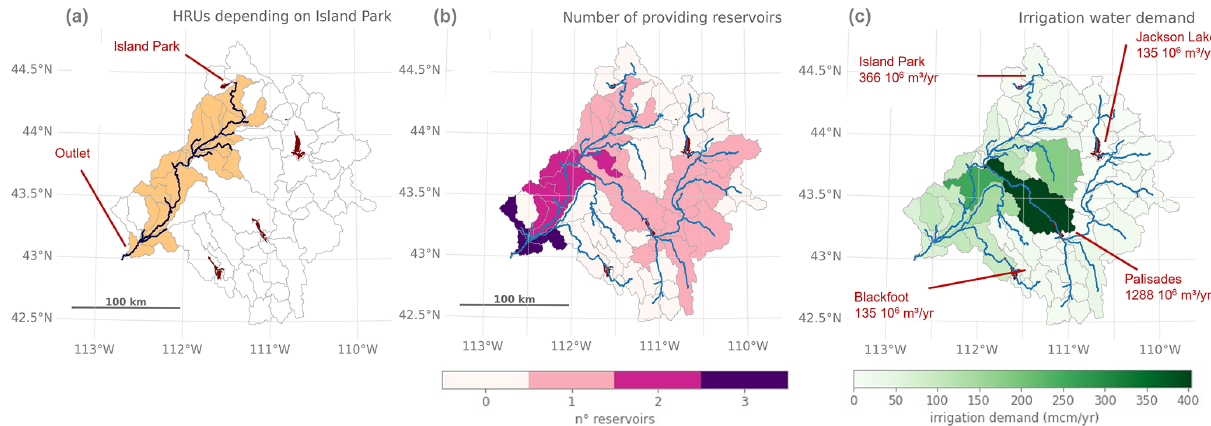
Figure 1. Illustration of the irrigation topology for the Snake River basin (with the basin outlet taken at American Falls reservoir, ID, USA). Selection of river segments and corresponding downstream HRUs of the Island Park reservoir (a) , number of reservoirs supplying water to each HRU (b) , and total irrigation water demand per HRU and reservoir calculated using the irrigation topology (c) . Reservoir locations are taken from GRanD, the river network from HDMA, and the irrigation demand is remapped from a gridded CLM simulation (see Sect. 3.2).